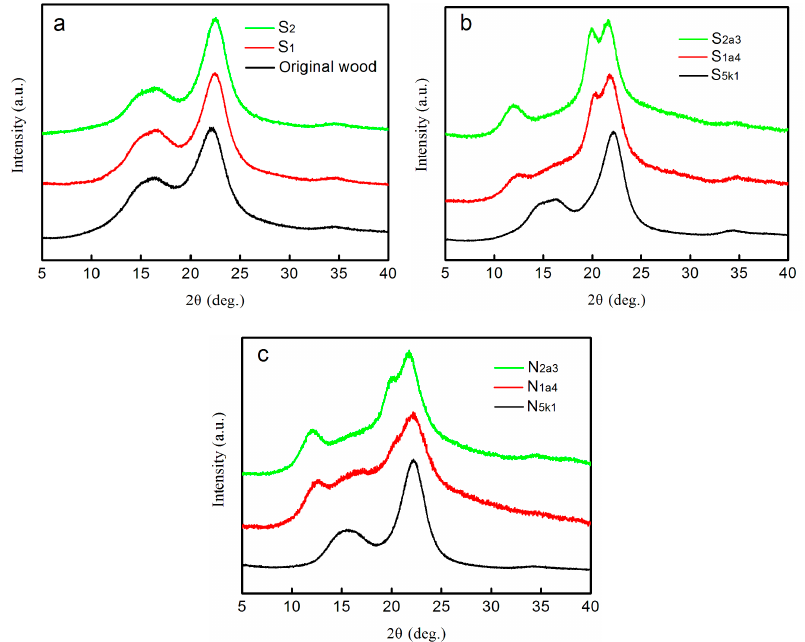
Figure 2. XRD patterns of the samples: ( a ) wood fibers of the original wood, S 1 , S 2 ; ( b ) purified pulps, S 5k1 , S 1a4 , and S 2a3 ; and ( c ) CNFs, N 5k1 , N 1a4 , and N 2a3.